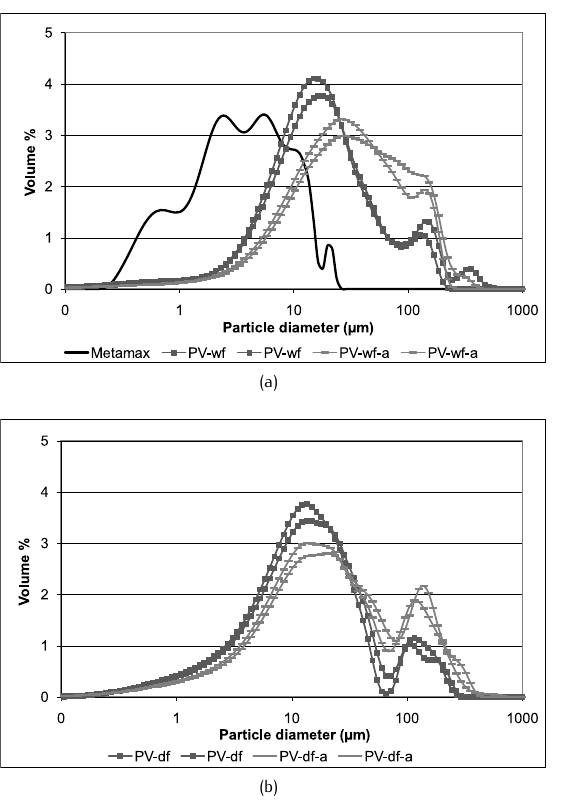
Figure 4. Particle size distribution of a) wet fractionated samples of PM and b) dry fractionated samples of